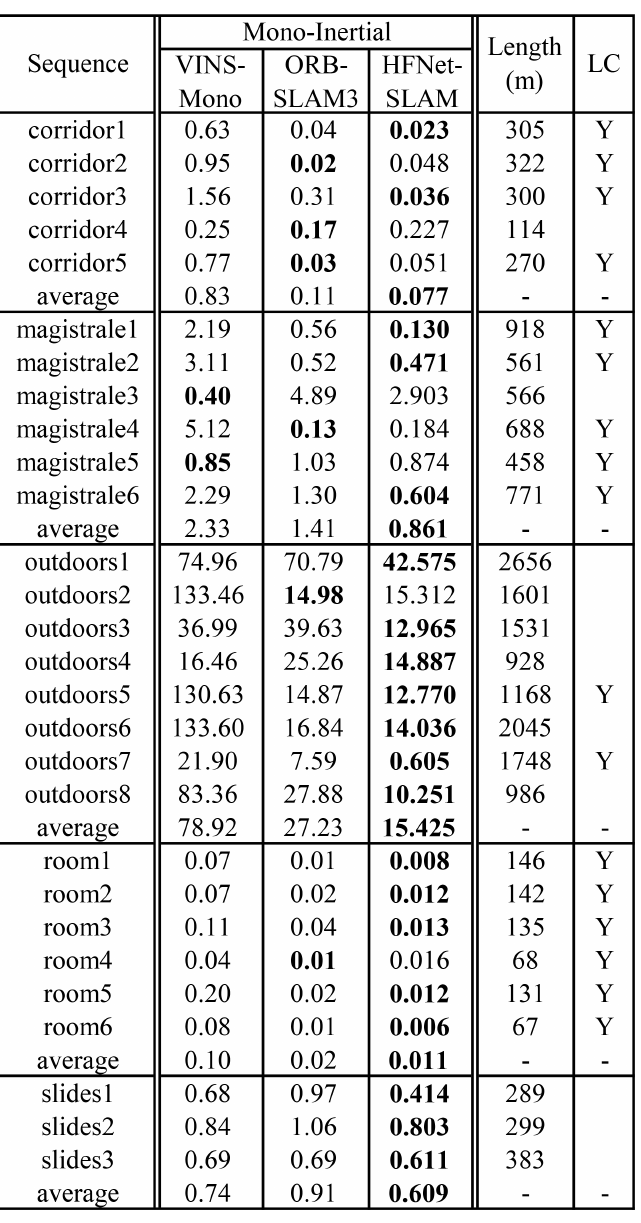
Figure 6. Comparisonresults in TUM-VI dataset (rms ATE in meters). The results of HFNet-SLAM are median of five executions. The measurements of other systems are provided by [1]. The bold values denote the smallest errors. LC means whether the loop closure may